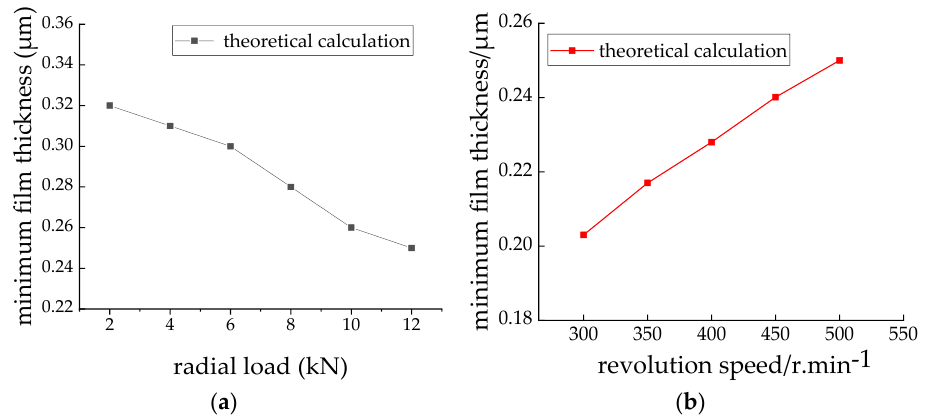
Figure 12. Theoretical minimum film thickness under different conditions. ( a ) radial load; ( b ) revolu- tion speed.